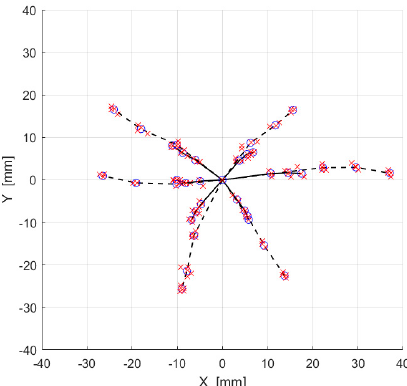
Figure 13. X-Y projection of the workspaces for prototype B (cross: experimental, circle: mean values; solid line: with antagonistic wires, dotted line: without antagonistic wires).